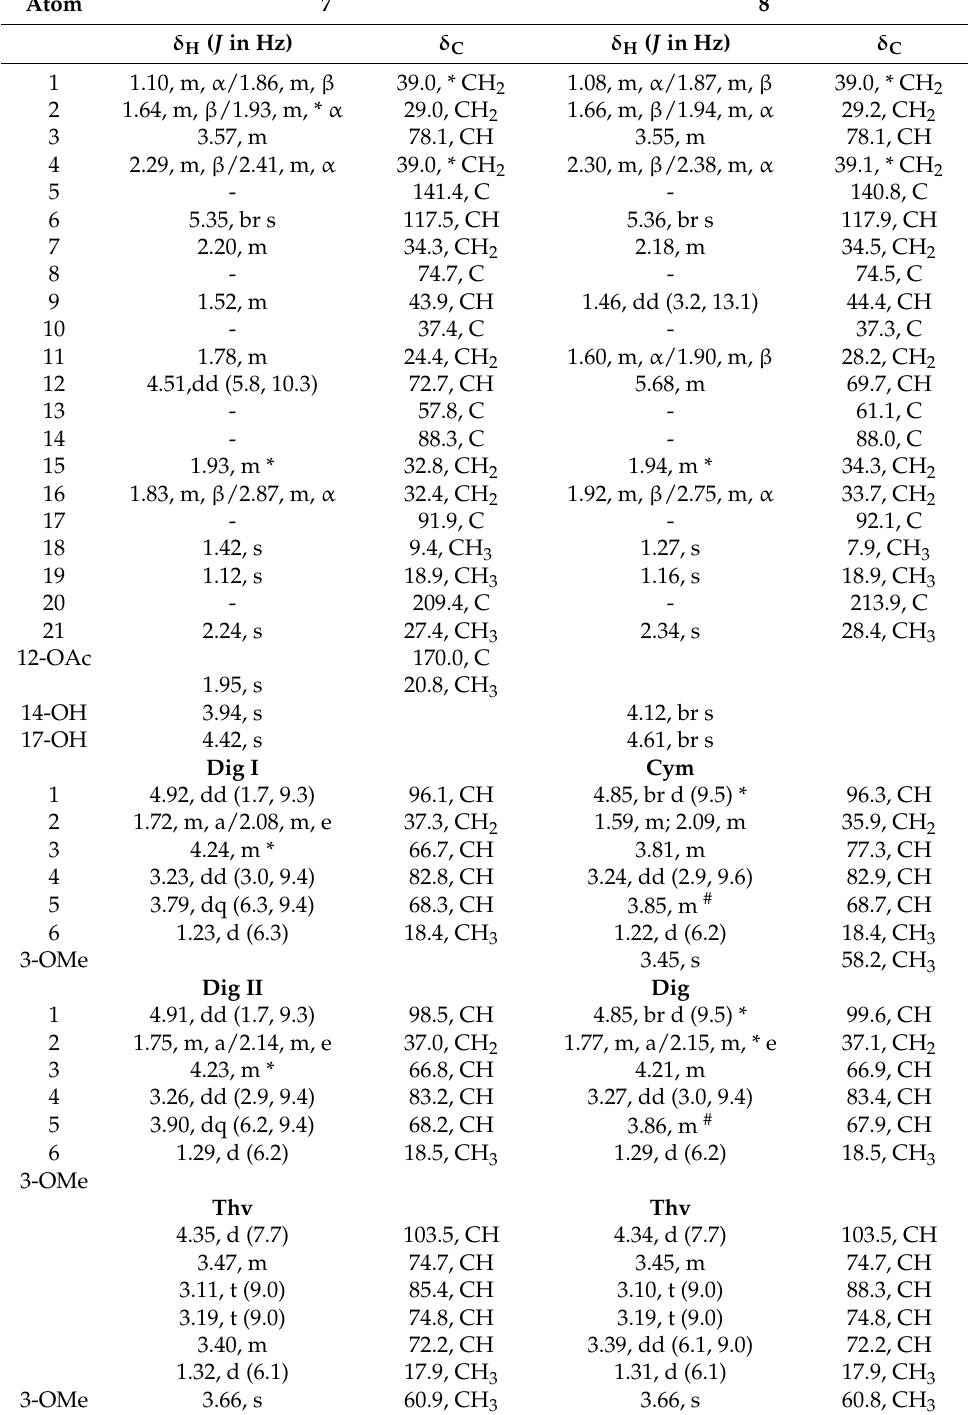
Table 3. The 1 H and 13 C NMR data for compounds 7 and 8 in CDCl 3